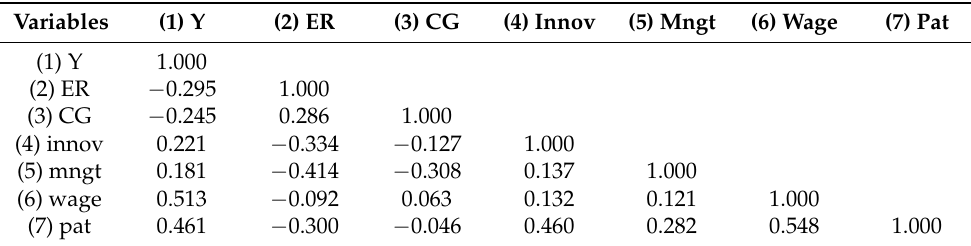
Table 2. Matrix of